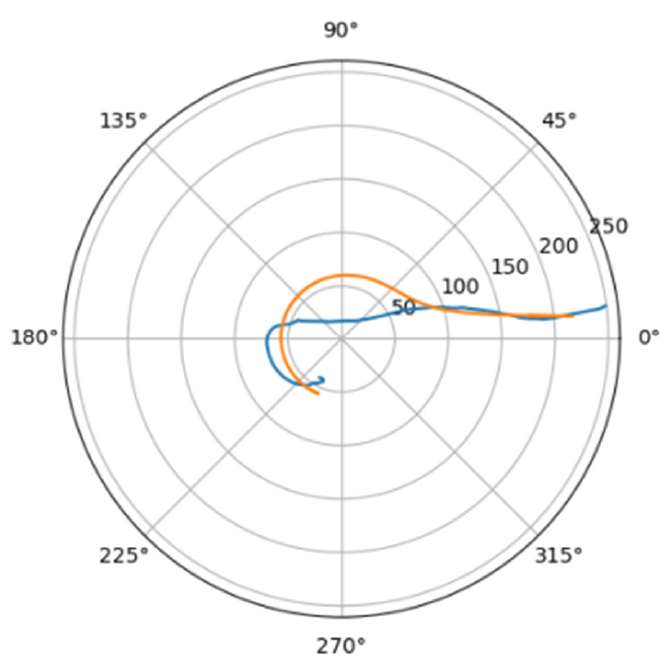
Figure 20. Approximations for hom_a.